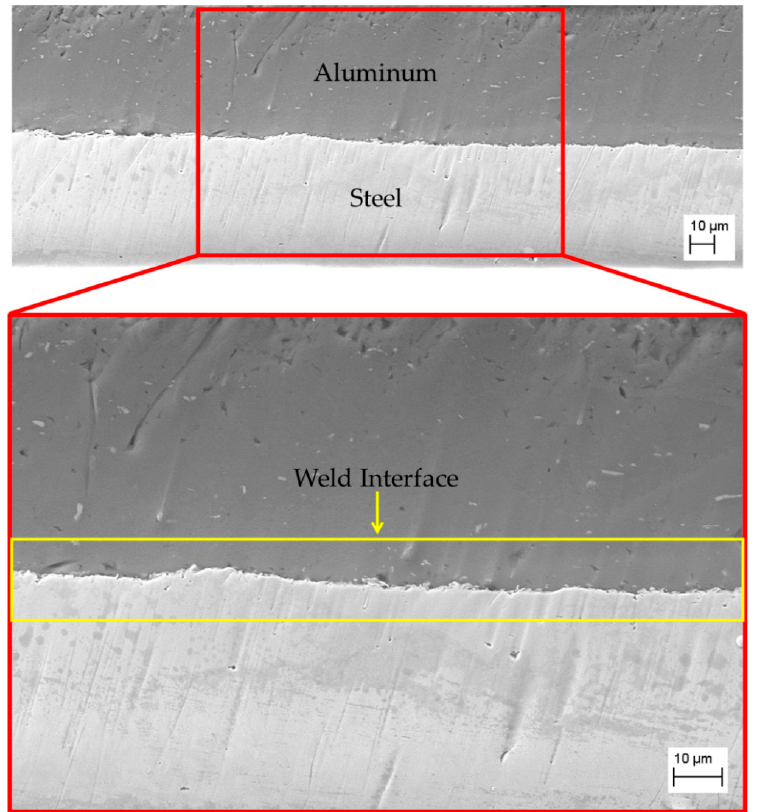
Figure 11. SEM images of a LIW sample at two di ff erent